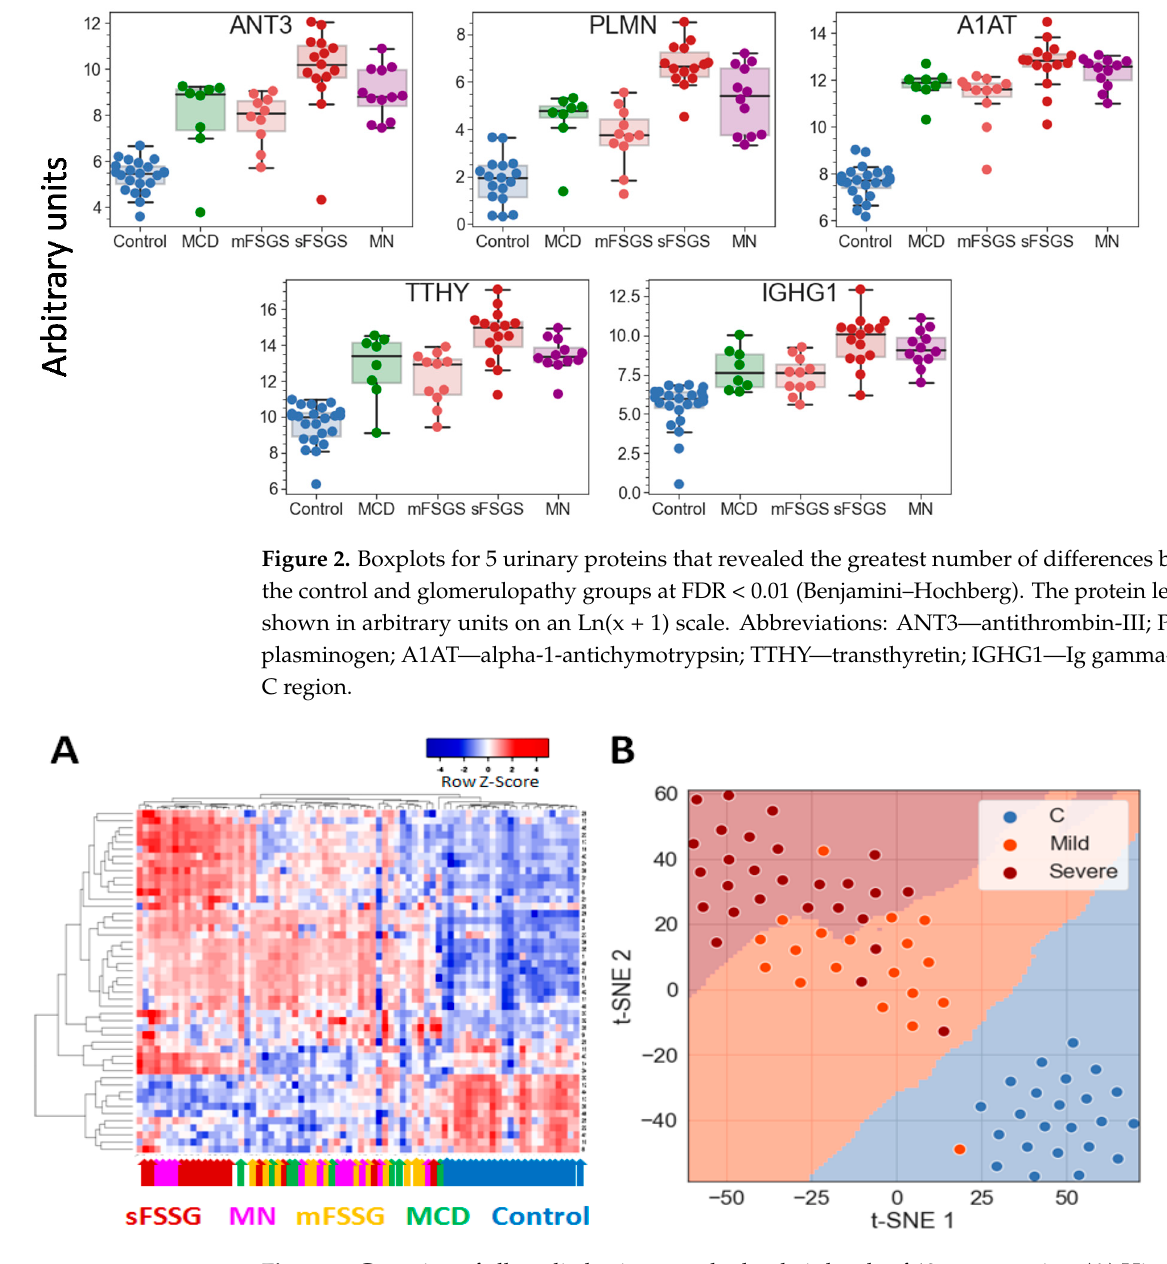
Figure 3. Grouping of all studied urine samples by their levels of 40 core proteins: ( A ) Hierarchical clustering of individual sample data and the 40 significantly different core proteins using the Pearson distance measurement method. The colored arrows indicate the clinical diagnosis of each particular sample. ( B ) Division of samples into three main groups using the PCA and t-SNE